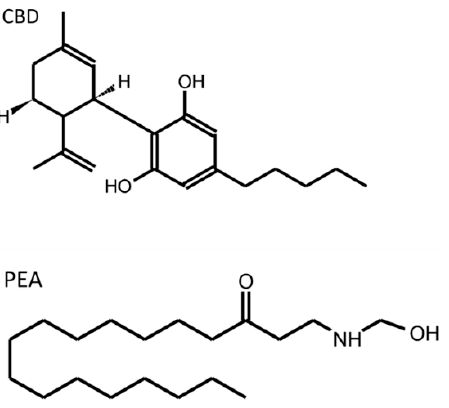
Figure 3. Chemical structure of cannabidiol (CBD) and palmitoylethanolamide (PEA). Molecules were drawn using http://biomodel.uah.es/en/DIY/JSME/draw.es.htm (accessed on 1 September 2022). The ECS is composed of cannabinoid receptors (CB1, CB2), their endogenous ligands (endocannabinoids, ECBs), and the enzymes involved in the biosynthesis and degradation of